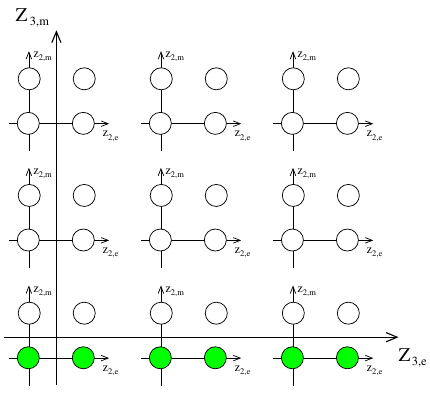
Figure 2 . (cid:0) = 1 . The Abelian lines are generated by ( q; g ) = (1 ; 0) and (0 ;